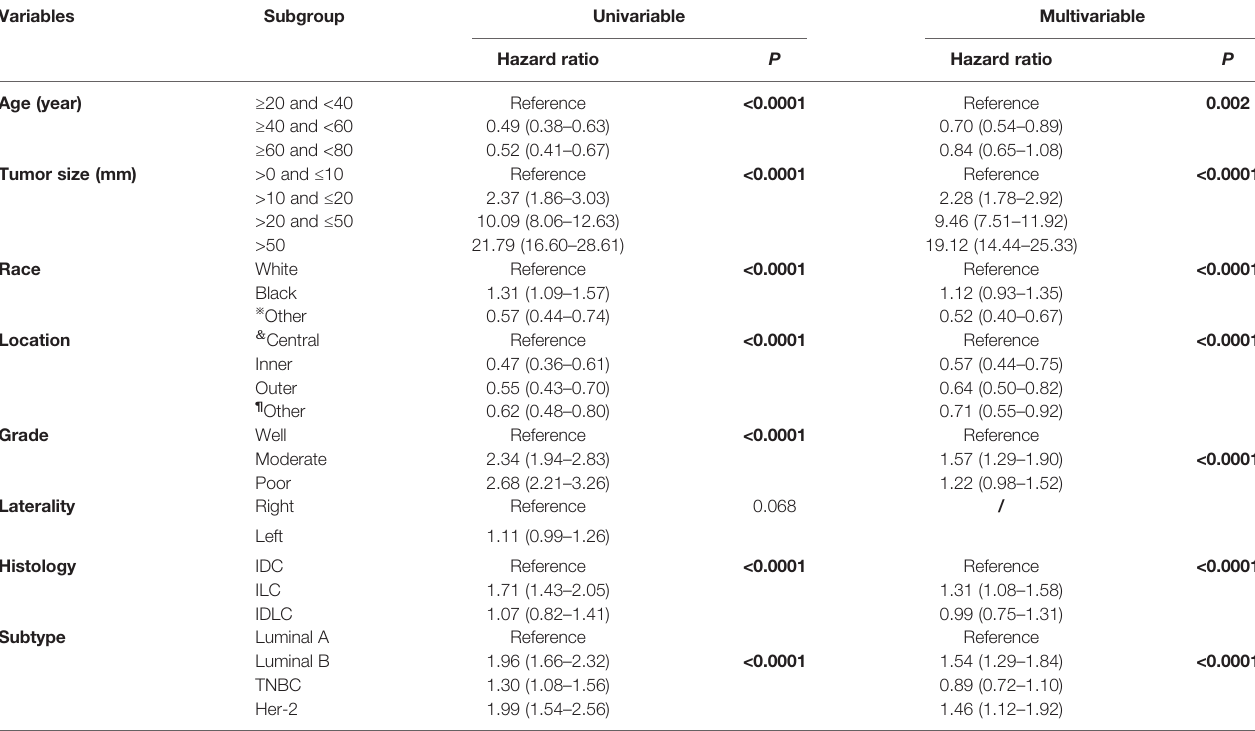
TABLE 2 | Univariate and multivariate logistic regression analyses of clinical variables correlated with distant metastasis in female breast cancer with negative lymph node status.